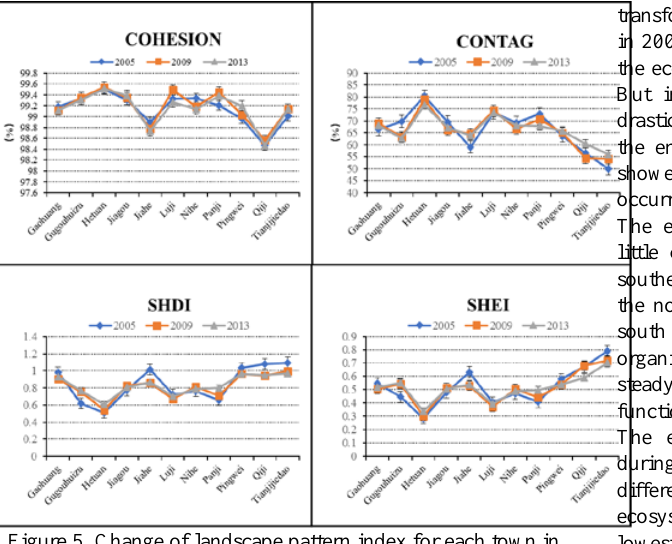
Figure 5. Change of landscape pattern index for each town in Panji District from 2005 to